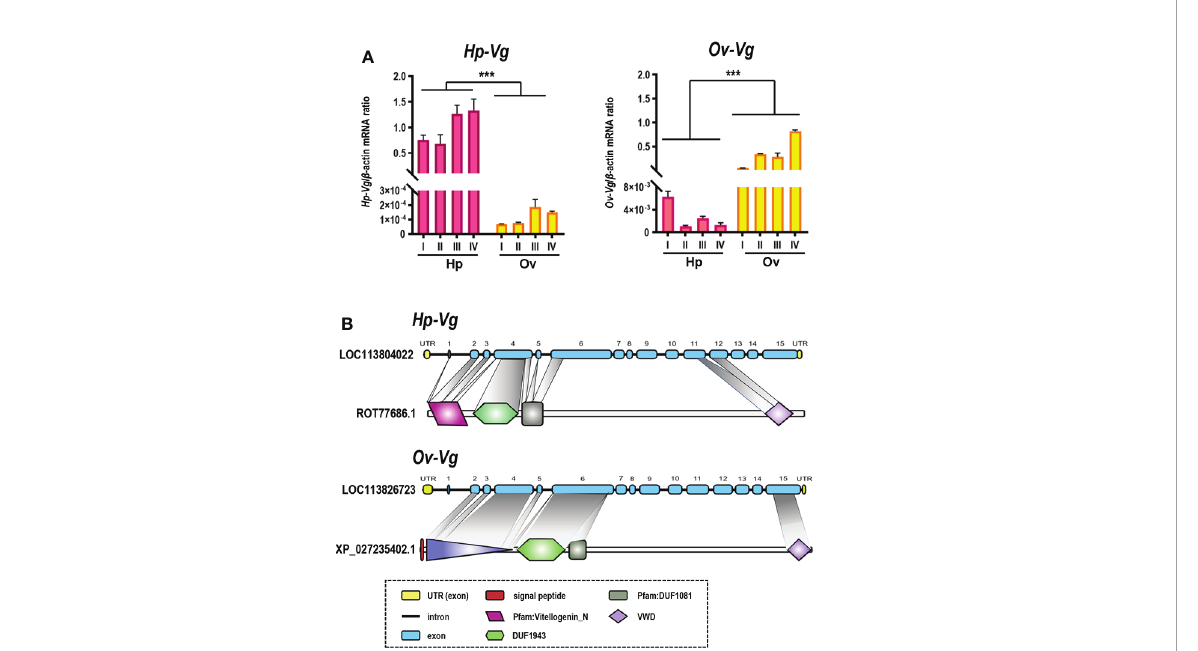
FIGURE 6 (A) RT-qPCR validation of two differentially expressed vitellogenin , named Hp-Vg as the hepatopancreatic type and Ov-Vg as the ovarian type. The X-axis is staging, left is hepatopancreatic, right is ovarian, Y-axis is sample CT to b -actin CT ratio. Values with different superscripts indicate statistical signi fi cance ( P < 0.05), calculated by one-way ANOVA. (B) Comparison of Hp-Vg and Ov-Vg structural domains (Hp-Vg: ROT77686.1, Ov-Vg: XP_027235402.1) and exon/intron organization of genes (Hp-Vg: LOC11380422, Ov-Vg: LOC113826723). The ORF and UTR of exons are marked with dark blue and empty boxes, respectively, and introns are marked with solid lines. Solid lines. The lengths of the elements are indicated as nucleotides. *** means signi fi cant